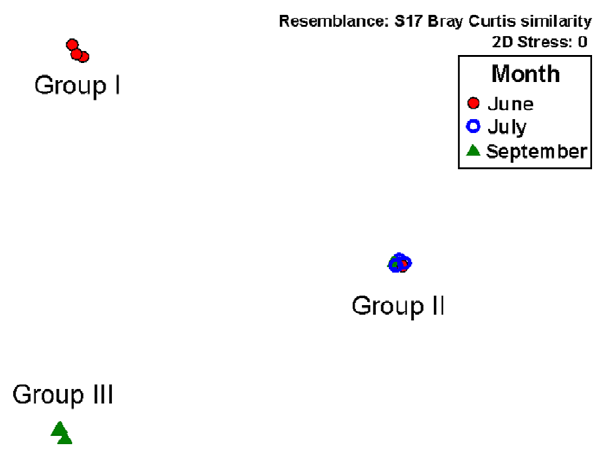
Figure 4. Non-metric multi-dimensional scaling (nMDS) ordi- nation of the bacterial community in salt marsh sediments. Resemblance matrix generated using Bray Curtis similarity and based on the relative abundance of taxa identified by PhyloChip analysis.